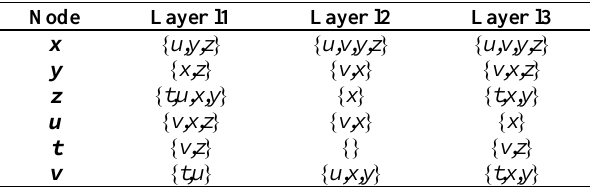
Table 1. Node neighbourhoods for each layer for MSN from Figure